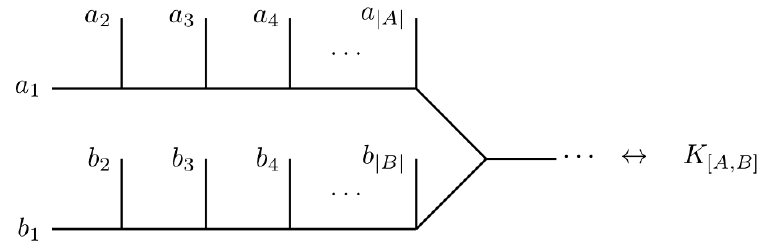
Figure 3 . The planar binary tree associated with the multiparticle superfield K